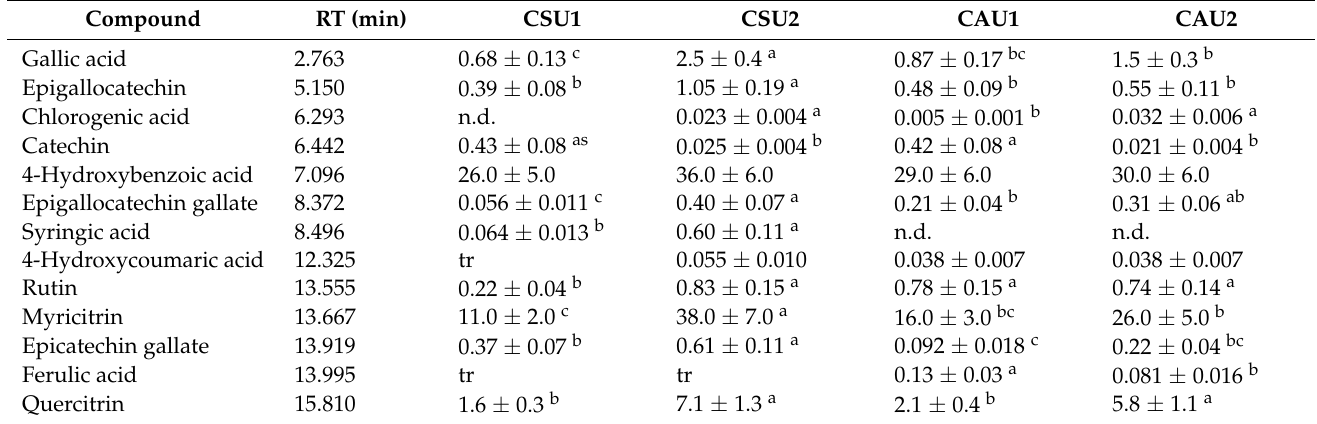
Table 2. Content (expressed in mg g − 1 ) of the identified polyphenols into the carob leaf UAE